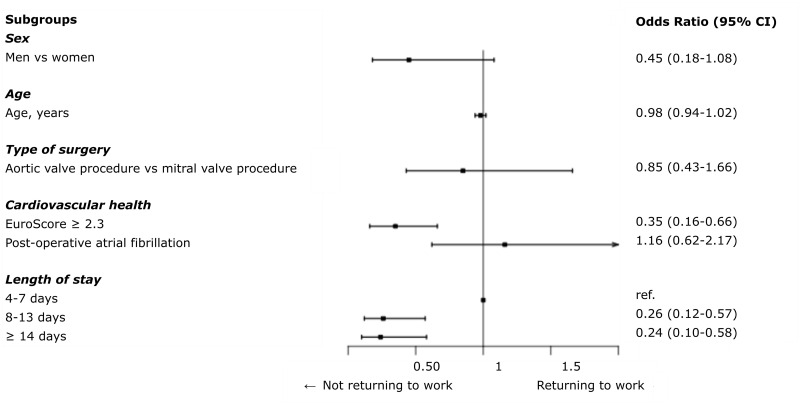
Factors associated with returning to the workforce.The figure illustrates the logistic regression model of factors associated with returning to the workforce, with time to return to work (weeks) as the underlying time scale.